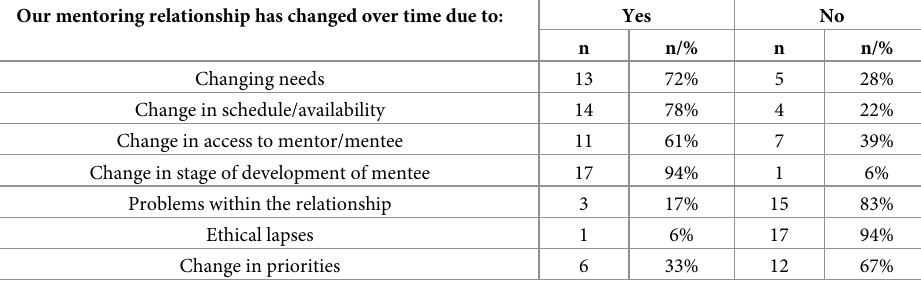
Table 7. Reasons that promote changes in mentoring